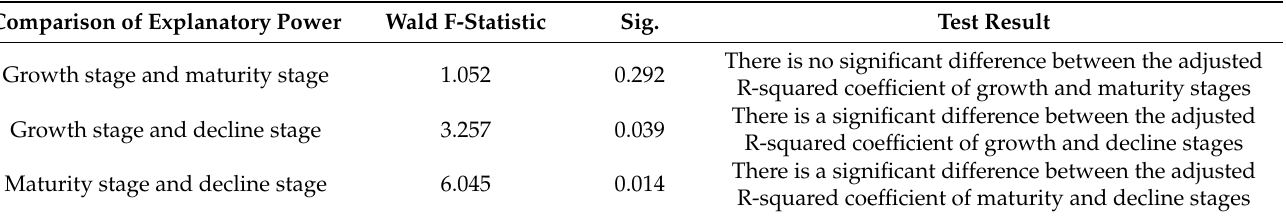
Table 13. Survey the significance of the difference in the adjusted R-squared coefficient of the regressions according to the firms’ life cycle in the second hypothesis (Wald test).